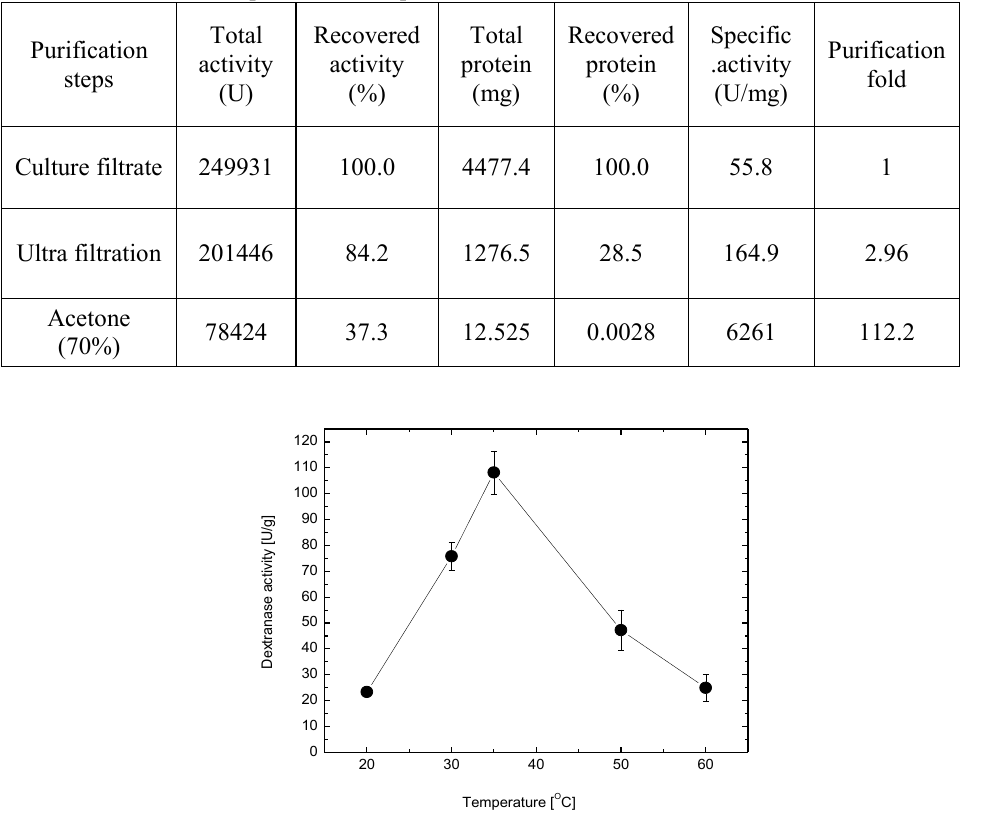
Figure 2. Effect of different temperature on dextranse production from Bacillus subtilis NRC-B233b